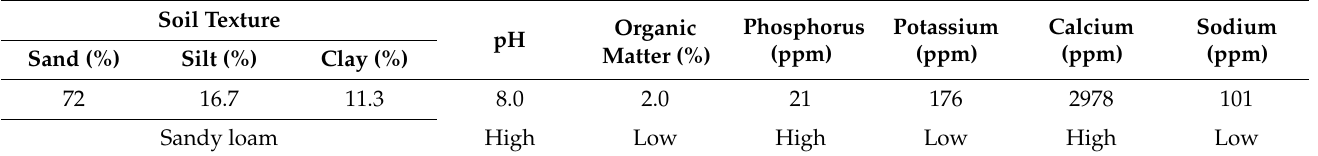
Table 1. Soil properties of the trial site.